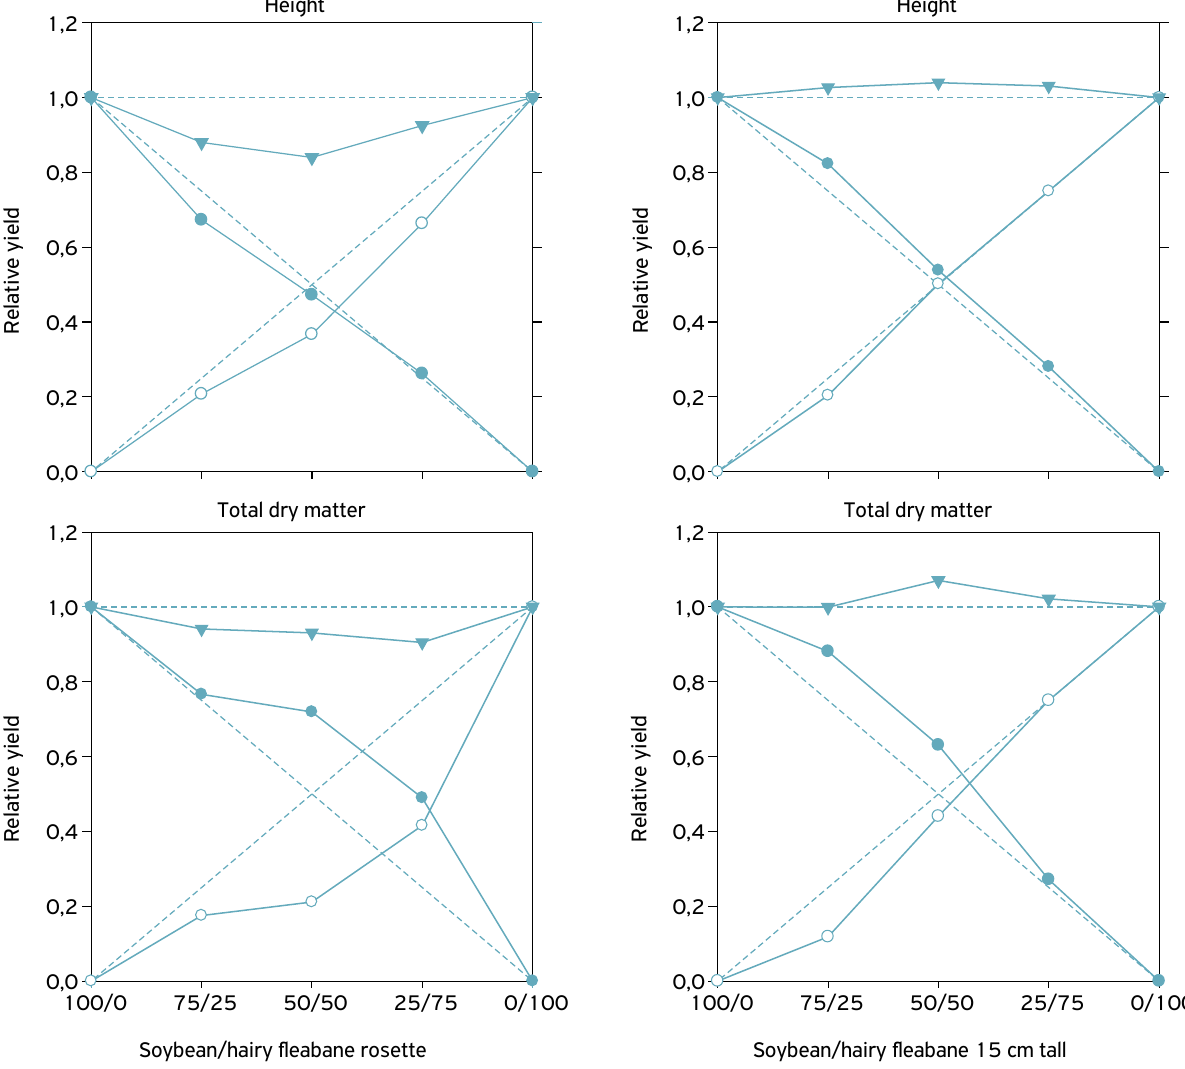
Figure 1. Relative yield (RY) and relative yield total (RYT) for height and total dry matter of soybean and hairy fleabane of different growth stages (rosette and 15 cm tall). ( ●) RY for soybean, ( ○ ) RY for hairy fleabane and (▼ ) RYT. The dashed line represents the hypothetical relatives yields whenever there is no interference between one specie over